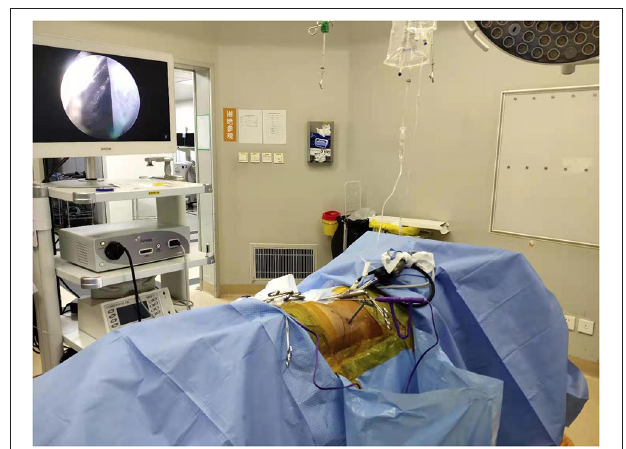
FIGURE 1 | Patient’s intraoperative